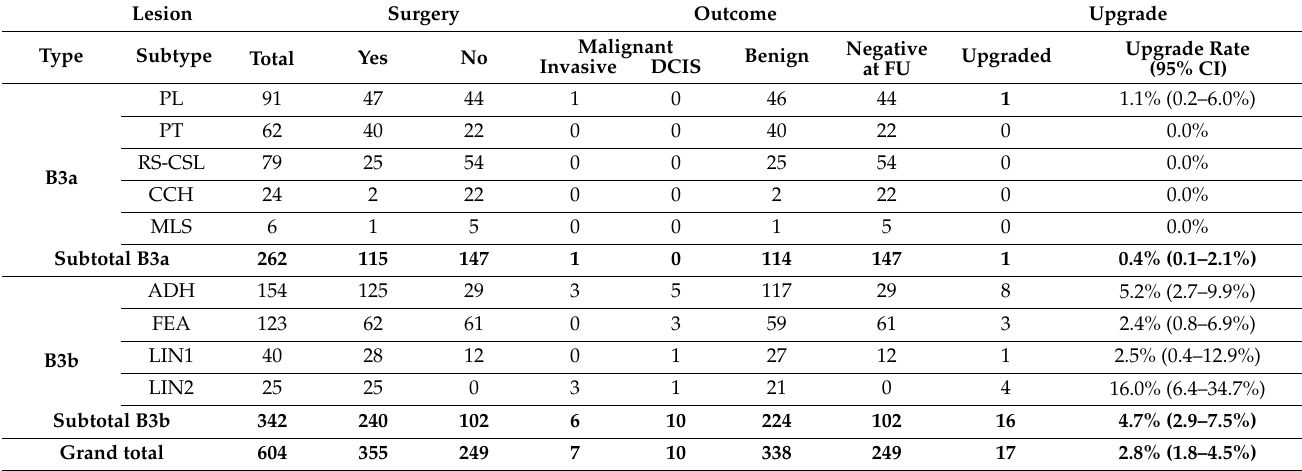
Table 2. Subtypes, management, and upgrade rates of the 604 included B3